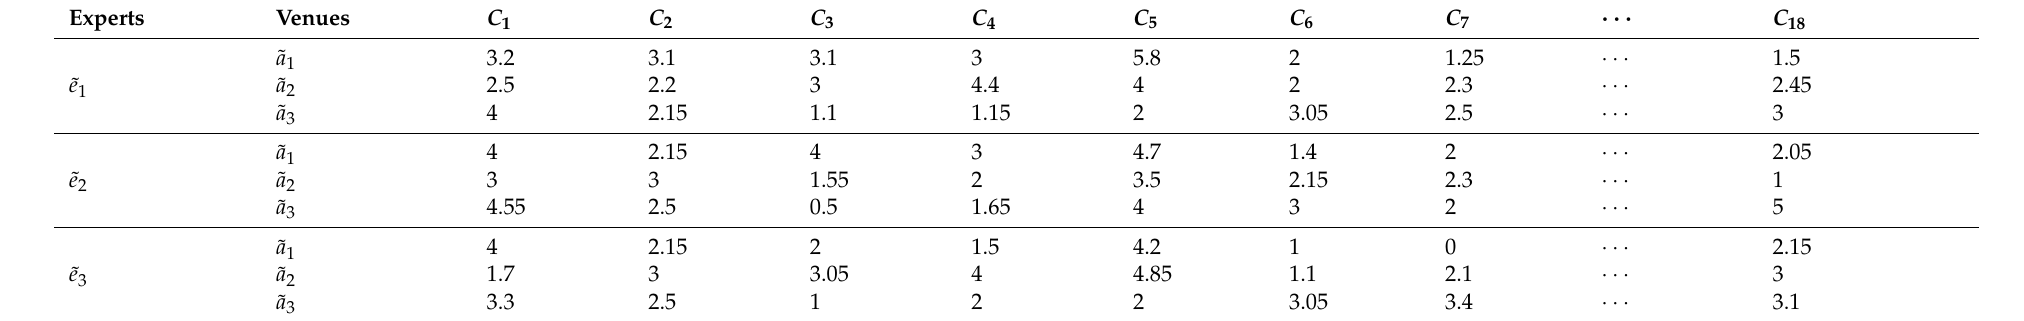
Table 5. Numerical representation of the assessment information.